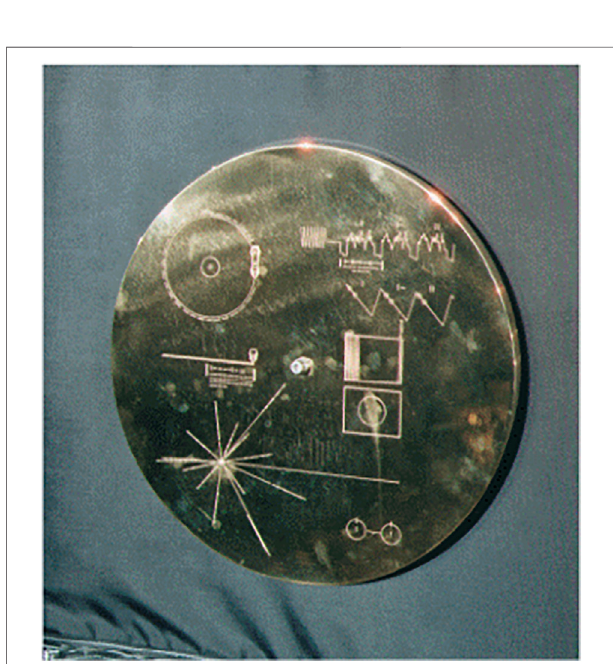
FIGURE 3 | The protective cover with instructions, mounted on Voyager spacecraft. Credit: NASA JPL.